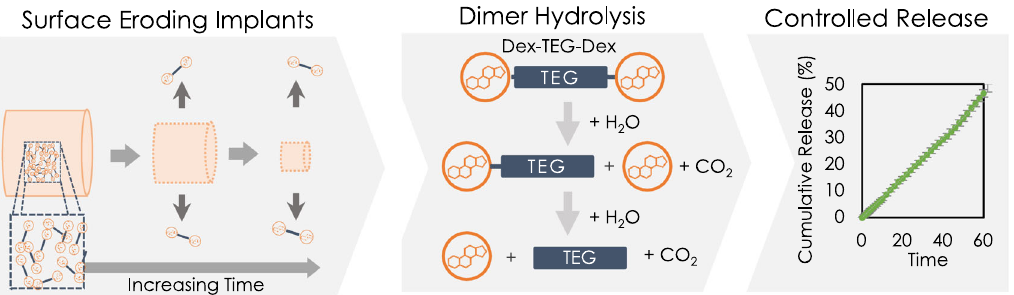
Fig. 3 Mechanism of drug release from a drug dimer material. Schematic illustrating the proposed mechanism for the release of free drug from a